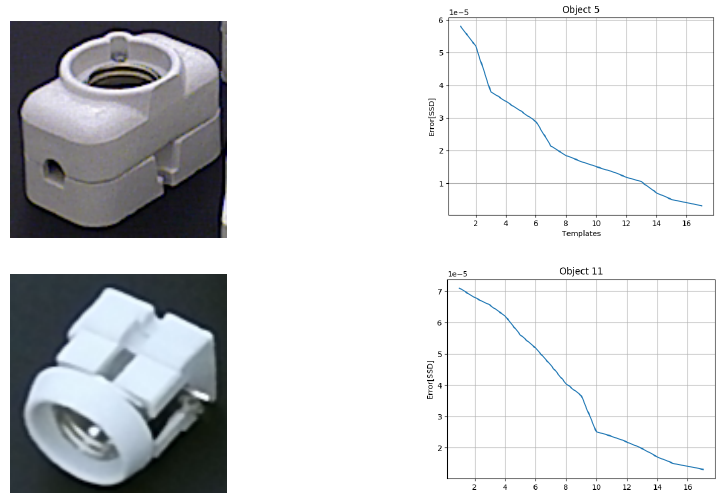
Figure 14. Comparing error function (SSD) vs. number of templates on Object 5 ( Top row ) and Object 11 ( bottom row ).